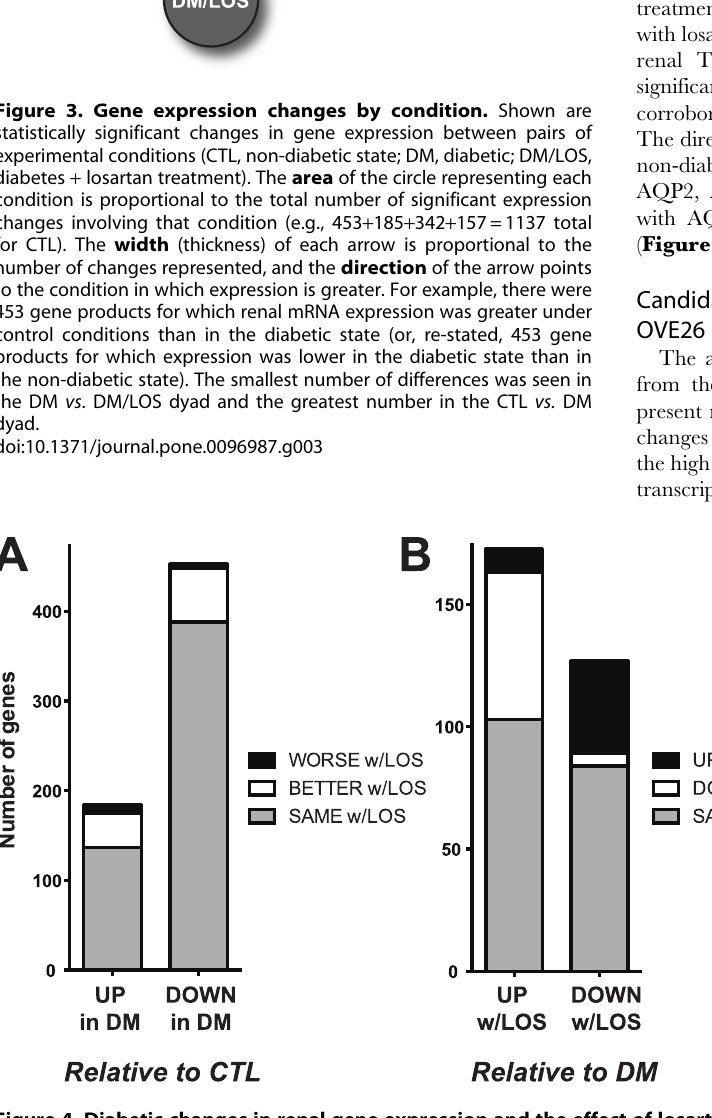
Figure 4. Diabetic changes in renal gene expression and the effect of losartan treatment. A . Effect of losartan treatment upon diabetes- associated changes in renal gene expression. Number of changes (UPregulation and DOWNregulation) in renal gene expression with diabetes, relative to control, grouped by the impact of losartan treatment. For most diabetic gene changes, there was no effect of losartan (SAME w/LOS; gray bars). Of the diabetic gene changes affected by losartan treatment, nearly all ameliorated the diabetic change (BETTER w/LOS; white bars) whereas very few exacerbated the change (WORSE w/LOS; black bars). B . Effect of diabetes upon gene expression changes associated with losartan treatment. Number of changes (UPregulation and DOWNregulation) in renal gene expression with losartan-treated diabetes (w/LOS), relative to untreated diabetes, assessed based upon the effect of diabetes alone. Most of the genes regulated by losartan were unaffected by diabetes alone (gray bars). These represent potential off-target effects of losartan treatment. However, of the genes regulated positively or negatively by losartan and also up- or down-regulated in diabetes, the vast majority of the losartan-associated changes ameliorated (white DOWN bar in UP column, and black UP bar in DOWN column) rather than exacerbated the